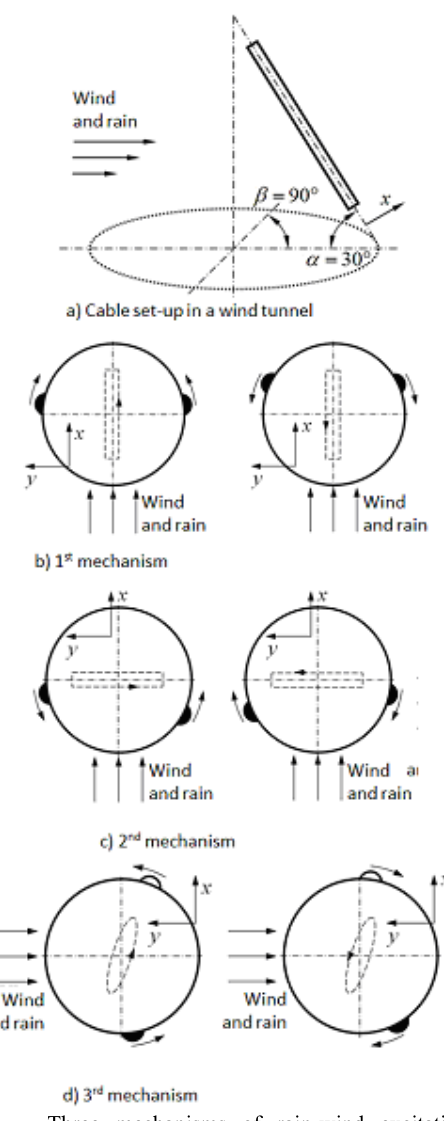
Fig. 7. Three mechanisms of rain-wind excitation, a) vibration within the wind direction, b) transverse vibration to the wind direction (two rivulets), c) transverse vibration to the wind direction (one rivulet) [9].